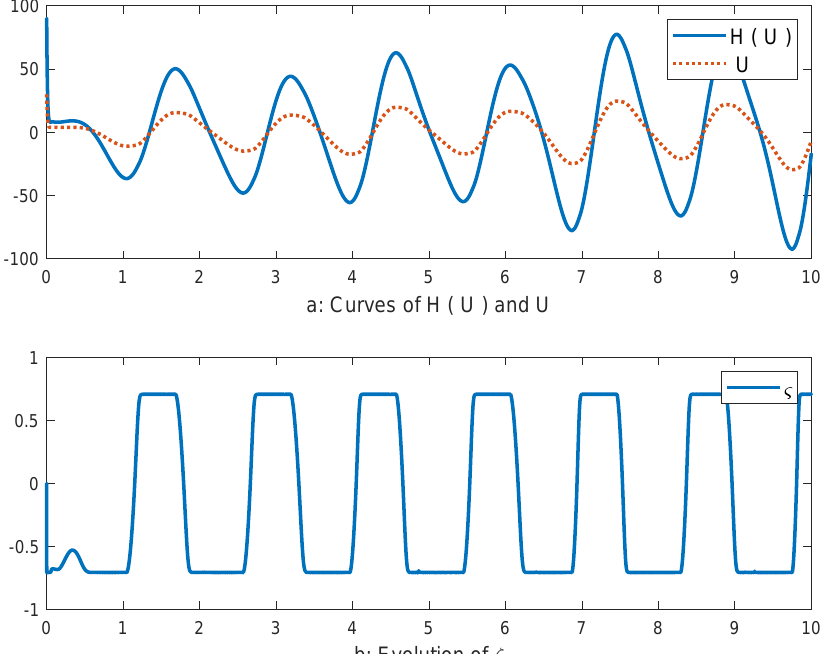
Figure 12. The control input and hysteresis